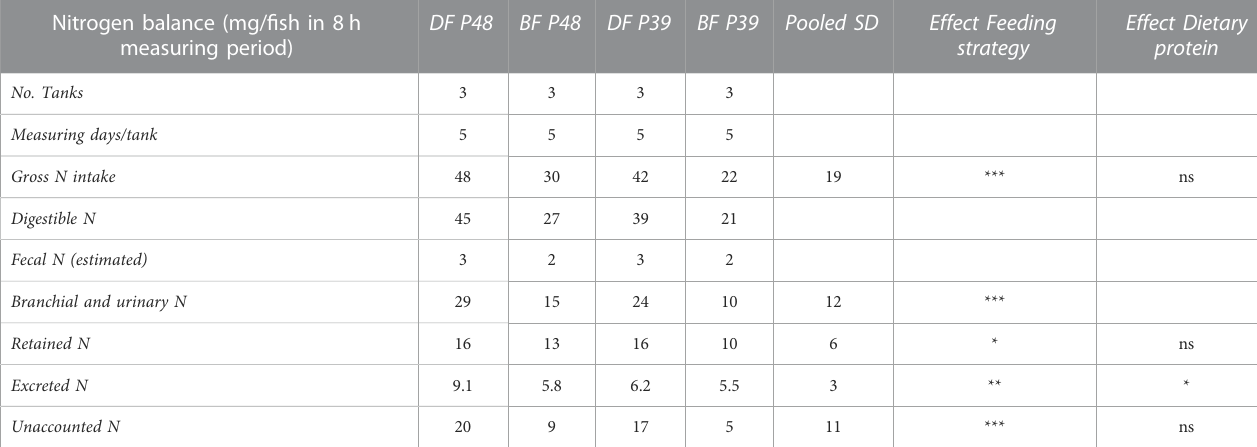
TABLE 4 Nitrogen balances in demand-fed and batch-fed carp tanks at two dietary protein levels. Nitrogen balance (mg/ fi sh in 8 h